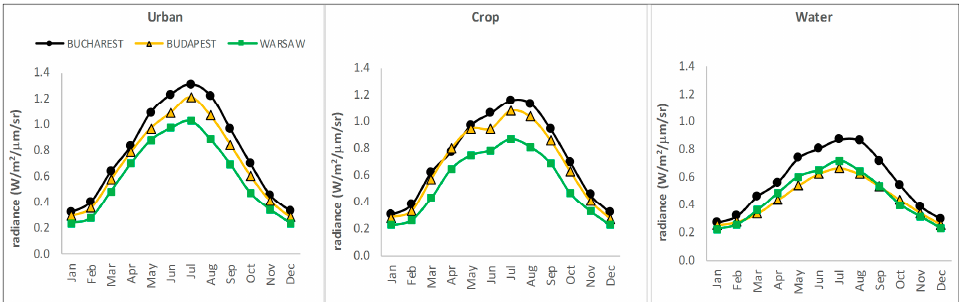
Figure 2. Mean monthly MIR radiance across cities for three classes: urban, cropland, and water. The simple difference and normalized difference data show similar seasonal patterns, but the normalization helps to underscore the differences in MIR radiance between urban and cropland covers (Figure 3). Differences are lowest in Bucharest and highest in Warsaw. In early spring (March) and autumn (September and October), the differences between Bucharest and Budapest are negligible but positive in Warsaw, suggesting that snow cover might be attenuating MIR radiance in Poland. In Budapest, negative values occurred both in April and during autumn. Negative values indicate higher MIR radiance from cropland than urban cover, which is to be expected from large expanses of MIR-bright bare soils that occur at planting and again at harvest.